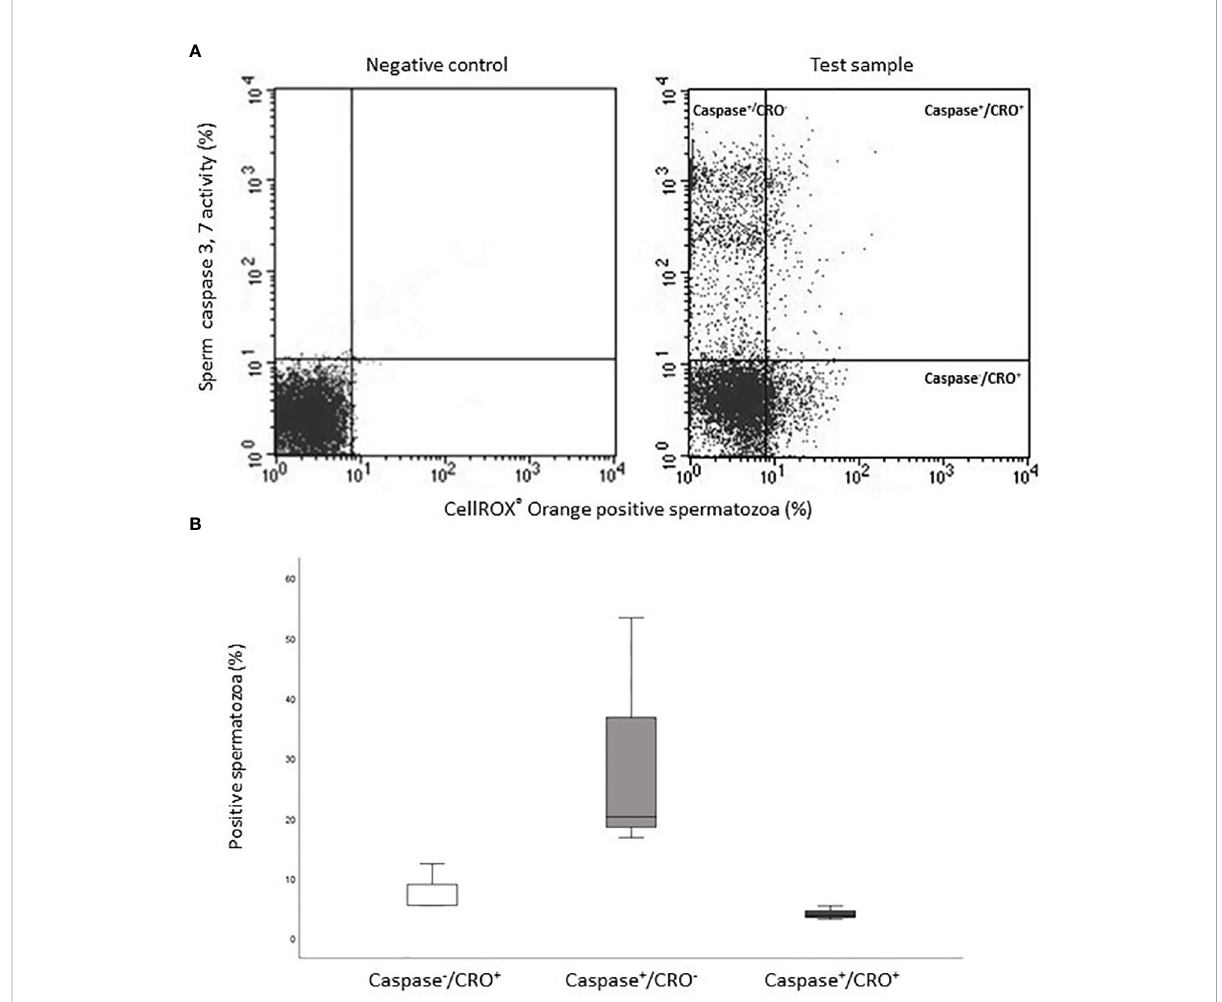
FIGURE 9 (A) Typical dot plots representing negative control (left) and test sample (right) related to CellROX ® Orange (red fl uorescence, CRO) and Caspase 3,7 activity evaluated by FLICA (green fl uorescence, Caspase). (B) Histograms of the percentages of CellROX ® Orange positive and Caspase 3, 7 activity negative spermatozoa (Caspase - /CRO + ), CellROX ® Orange negative and Caspase 3, 7 activity positive spermatozoa (Caspase + /CRO - ) and CellROX ® Orange and Caspase 3, 7 activity double positive spermatozoa (Caspase + /CRO + ),